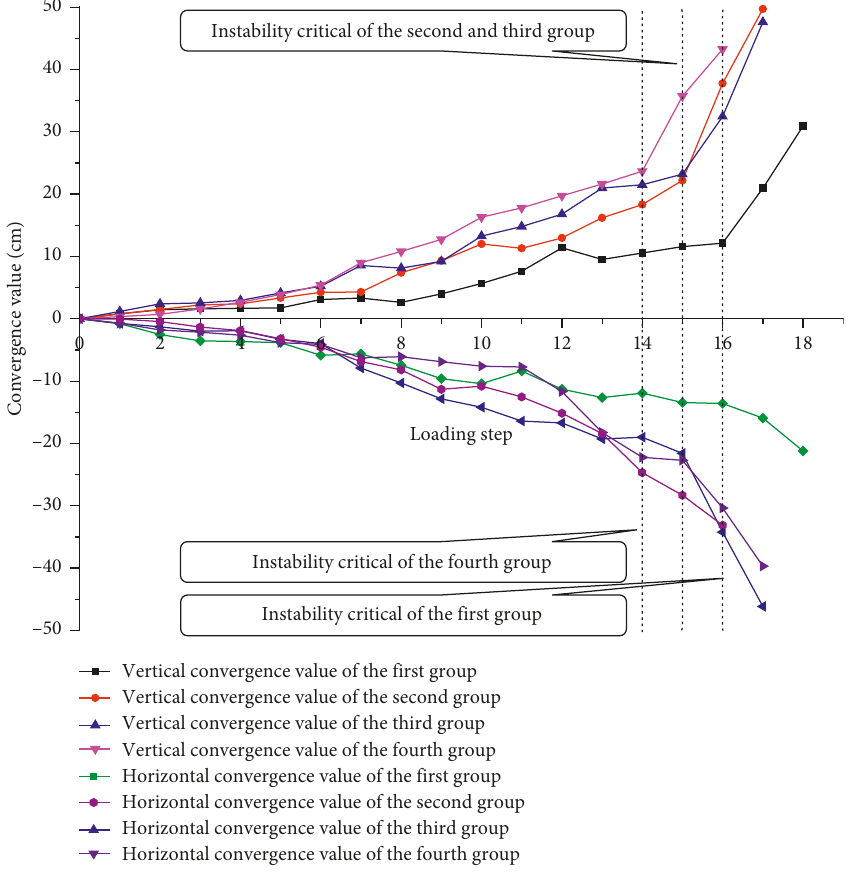
Figure 10: Convergence value of horizontal and vertical directions of segment lining.